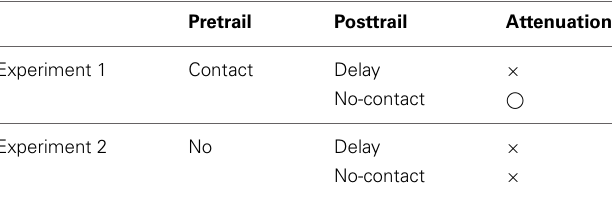
Table 2 | Summary of results of Bays et al. (2006).